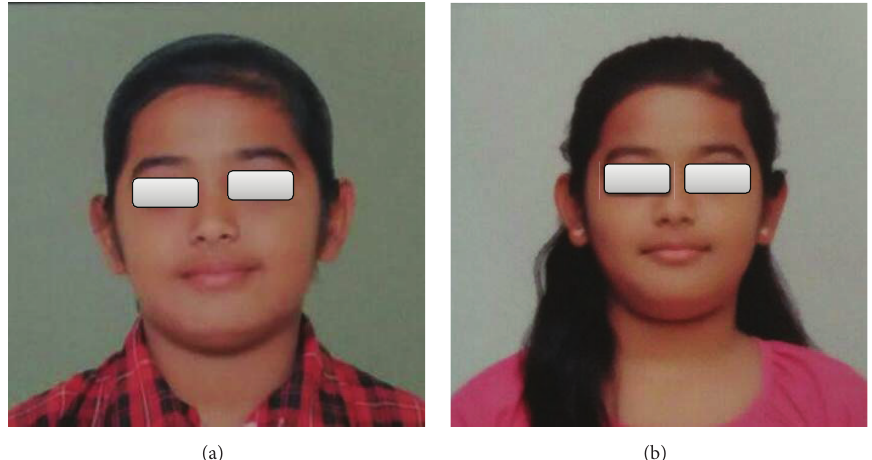
Figure 1: Facial images. (a) Depression just above the corner of the mouth and the lips were slightly inward at the corner of the mouth. (b) Deformities were refrained after crossbite correction.